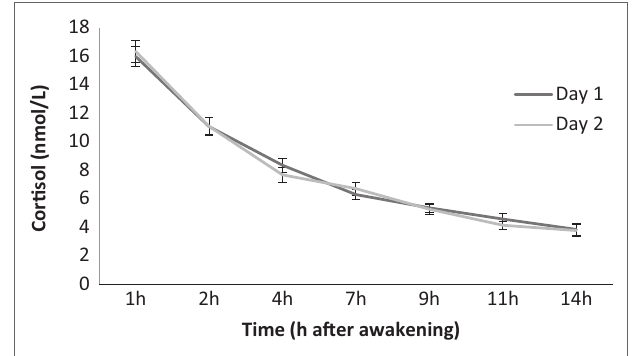
FIGURE 1 | Diurnal cortisol profile of each day (raw data).